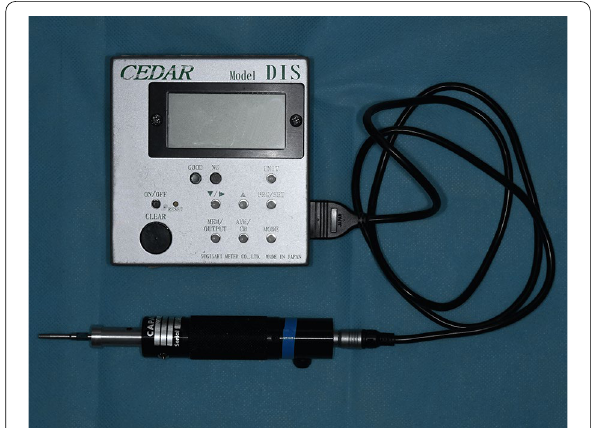
Fig. 3 Digital gauge used to measure torque values when placing and removing